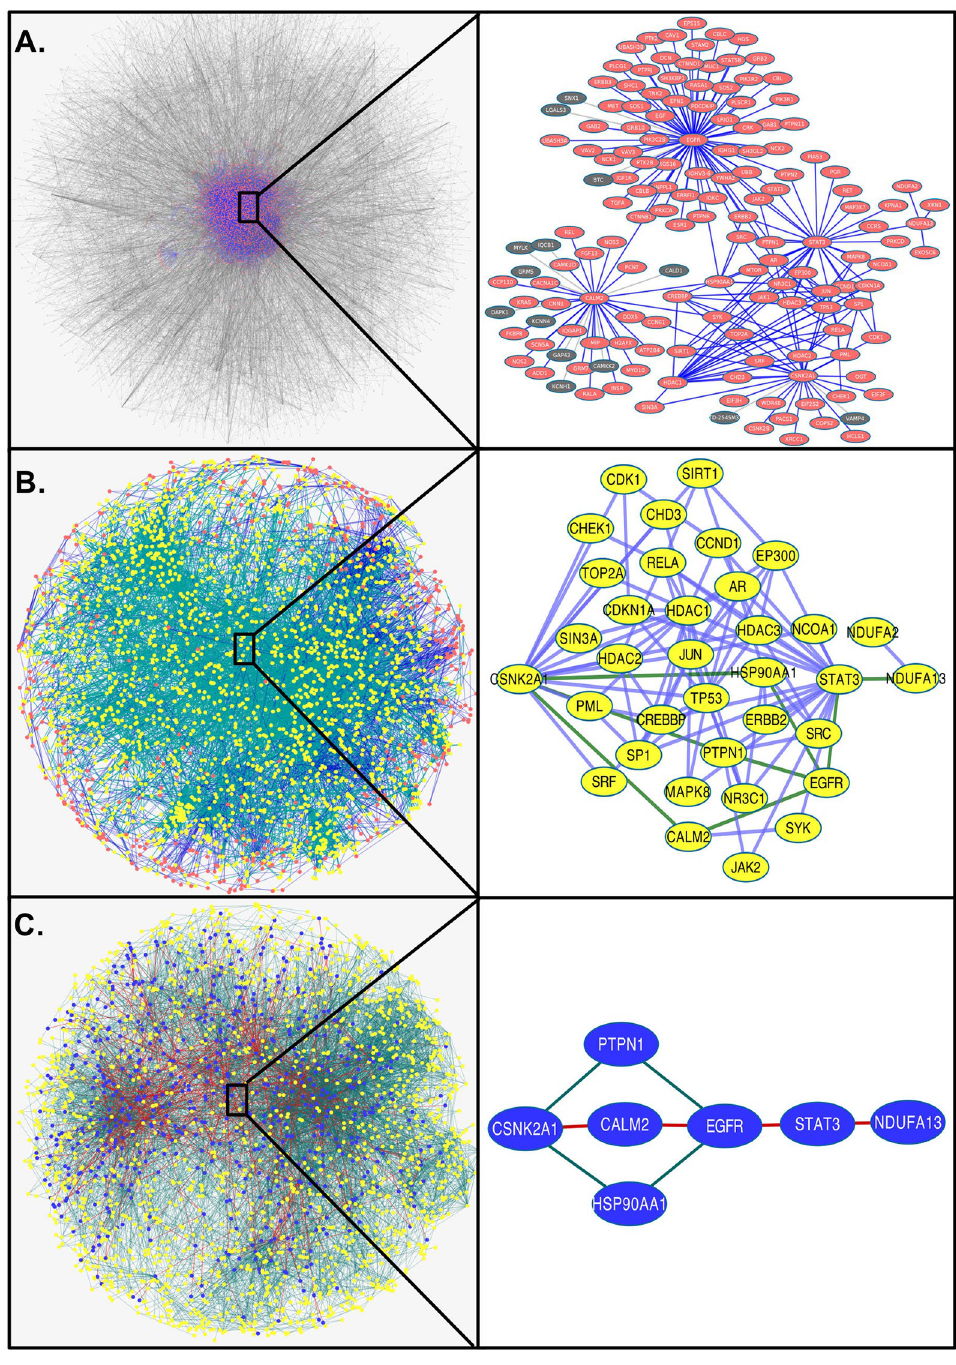
Fig 3. Development of a GBM-specific significant network from HPPIN. (A) A human protein-protein interactome network (HPPIN) was established based on experimentally validated interactome data of STRING database (left panel: the total network where nodes and edges are marked in grey). The SMIN was extracted from the HPPIN as signaling- metabolic interconnected path-dependent network between fourteen signaling and six groups of metabolic pathways as indicated in Fig 2 (highlighted as orange nodes and blue edges within the HPPIN on the left panel). The interconnections in the SMIN between one signaling (CSNK2A1) and one metabolic (NDUFA13) pathway protein through PPIs were highlighted on the right panel. (B) A GBM-specific network (left panel with yellow nodes and green edges) was developed from the SMIN (orange nodes and blue edges within the total background network) considering interconnecting paths with at least one differentially expressed protein identified from comparative proteome analysis of U87MG